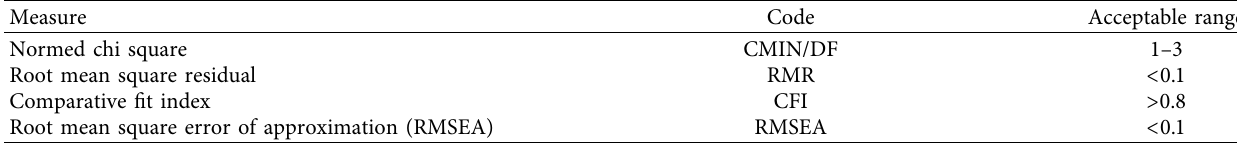
Table 4: Summary of goodness-of-fit cutoff values (source: [32].